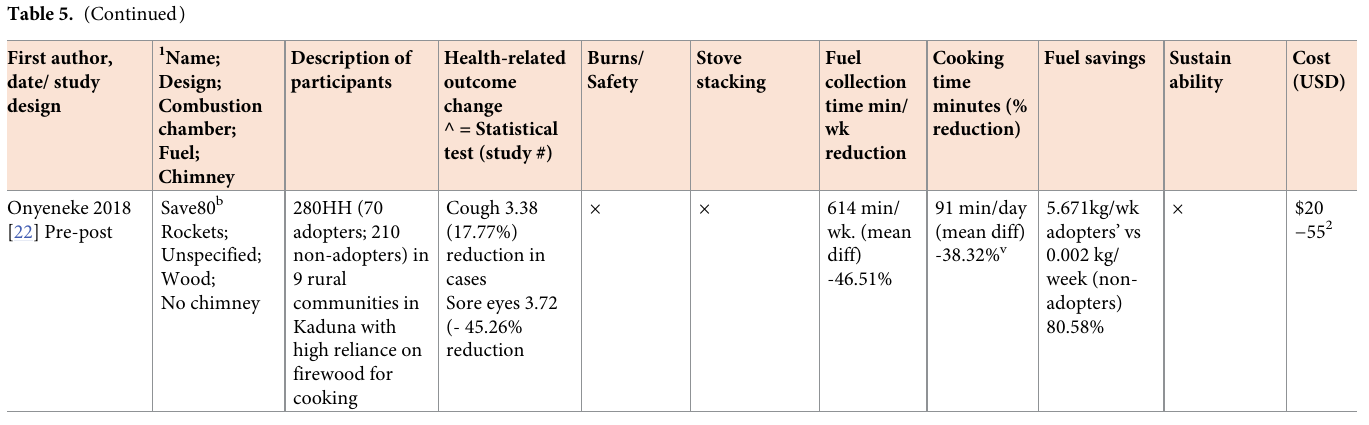
Abbreviations: TLUD: Top Lit Up Draft. I = Intervention Group; C = Control Group; n = number of observations; HH = households; ALRI = acute lower respiratory infections; SOB = Shortness of Breath; CAPs = Cooking and Pneumonia Study;; SBP = Systolic Blood Pressure; DBP = Diastolic Blood Pressure; IRR = Incidence